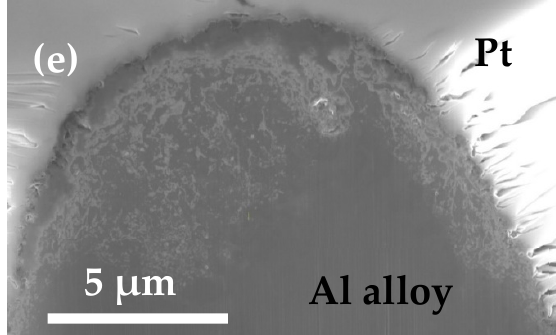
Figure 8. SEM images of conical microstructures for 33 J/cm 2 with five scan repetitions: ( a ) conical microstructures (observed with 52° sample tilt), with an impurity particle and the site of FIB milling; ( b ) close-up of the conical structures’ slopes with the contrast enhanced, ripples are observable (observed with 52° sample tilt); ( c ) tip of a conical microstructure before cleaning in acetone; ( d ) slope of a conical microstructure after cleaning in acetone; ( e ) internal content of a conical structure sectioned in half by FIB (observed with 52° sample tilt), a protective layer of platinum is deposited on top. Table 6. Average distance between cone tops per fluence.